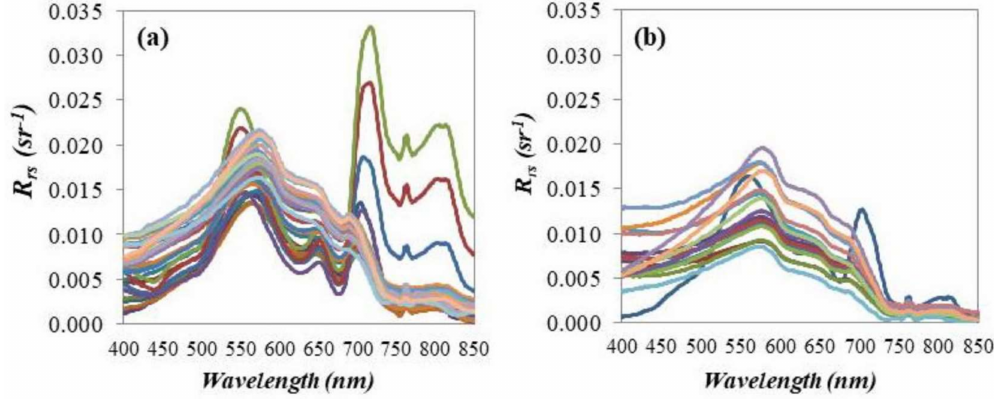
Figure 2. The R rs spectra considering the sampling points raised in BAR1 ( a ) and BAR2 ( b )